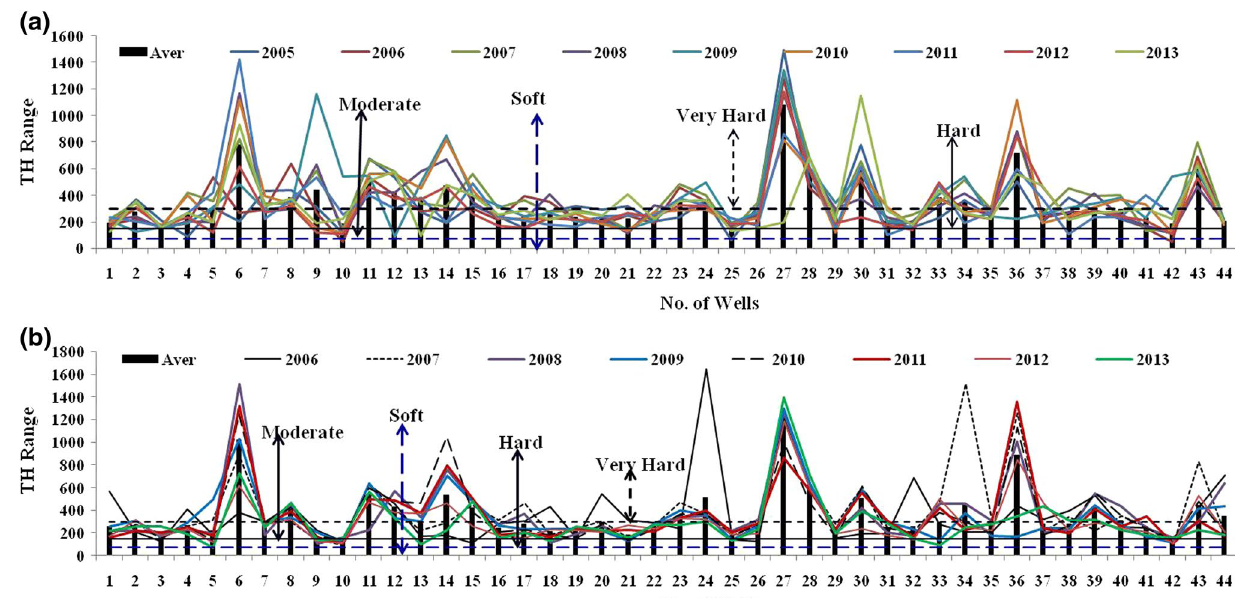
Fig. 13 a Nine-year (2005–2013) temporal representation of TH value during pre-monsoon. b Nine-year (2006–2013) temporal representation of TH value during post-monsoon